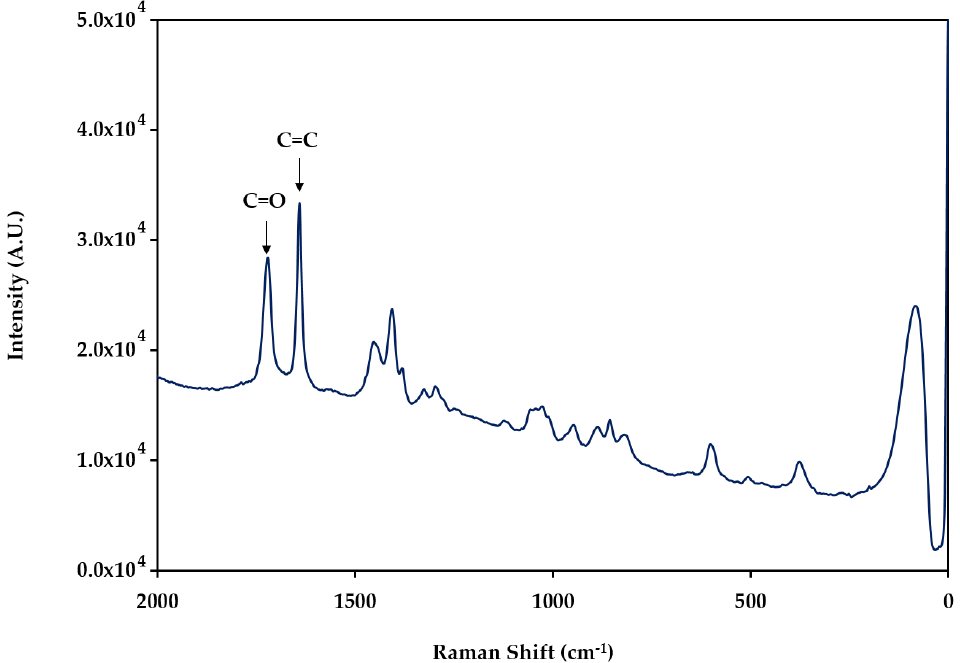
Figure 3. The Raman spectrum of the synthesized polymer poly(ionic liquid).